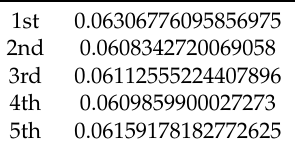
Table 5. NRMSD in the 5 different test samples based on the model in Table 4.